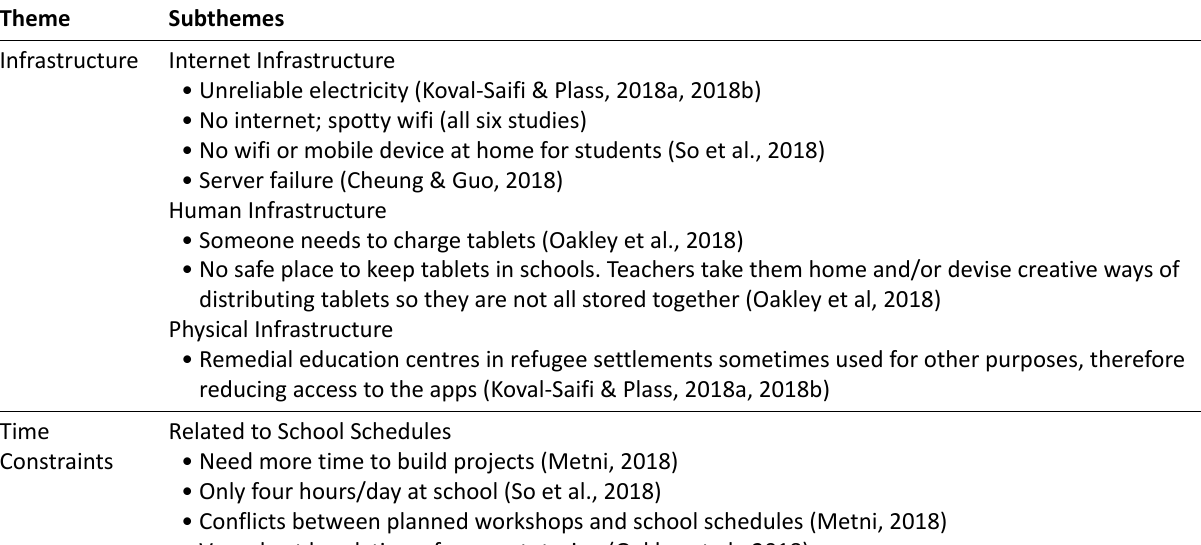
Table 3. Thematic analysis of contextual